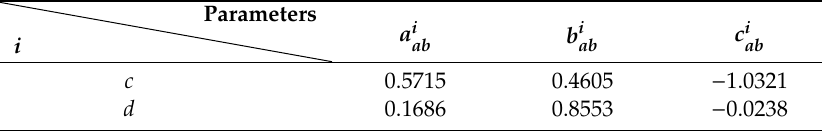
Table A2. Fitting parameters of charge-discharge absorption power Pab.